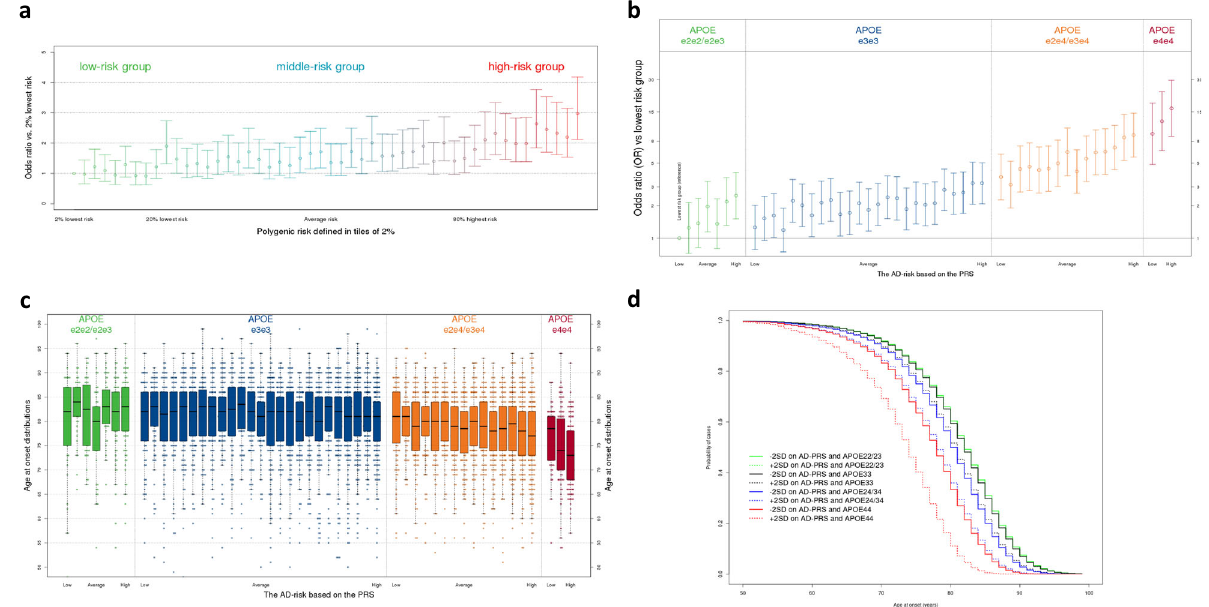
Fig. 5 Polygenic Risk Scores APOE strati fi cation for AD in n = 12,386 biologically independent samples from GR@ACE/DEGESCO. a The AD risk of PRS groups compared to those with the 2% lowest risk. The 2% highest risk had a 3.0-fold (95% CI [2.12 – 4.18], p = 3.2 × 10 − 10 ) increased risk compared with those with the 2% lowest risk. No interaction was found between the PRS and APOE genotypes ( p value = 0.76). b The AD risk strati fi ed by PRS and APOE risk groups compared to the lowest risk group (OR 95% CI). Association was found between highest and lowest-PRS percentiles within the APOE genotype groups: ɛ 2 ɛ 2/ ɛ 2 ɛ 3 carriers (OR = 2.48 [1.51 – 4.08], p = 3.4 × 10 − 4 ), ɛ 3 ɛ 3 carriers (OR = 2.67 [1.93 – 3.69], p = 3.5 × 10 − 9 ), ɛ 2 ɛ 4/ ɛ 3 ɛ 4 carriers (OR =